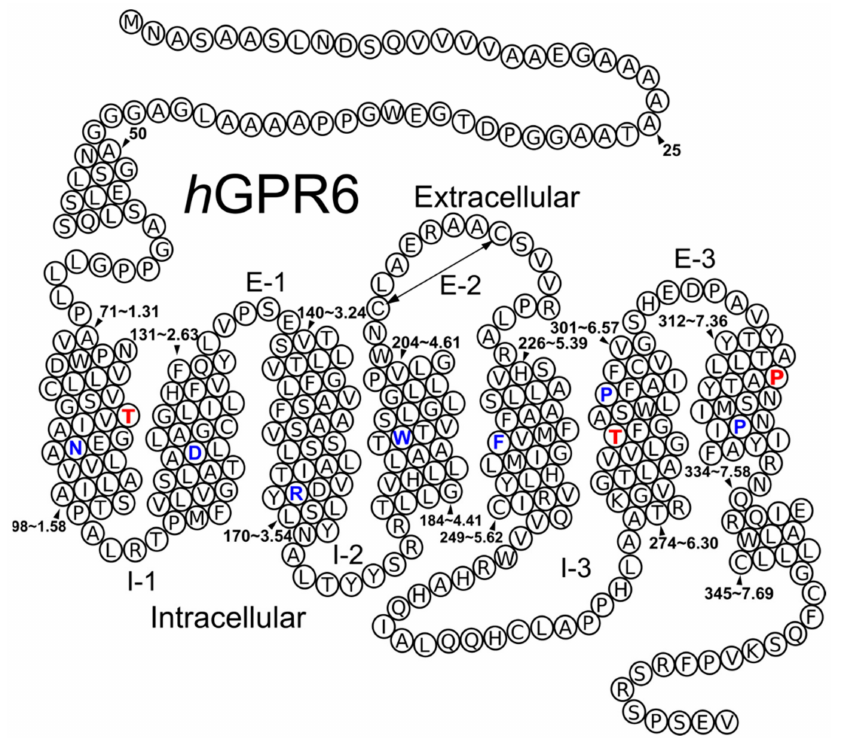
Figure 1. Helix net representation of the human GPR6 sequence. The most highly conserved residue in each helix is colored blue. A key disulfide bridge between the extracellular loop 2 (EC-2) is indicated by a double headed arrow. Black arrowheads indicate specific residue numbers in the GPR6 sequence (absolute and Ballesteros–Weinstein numbering). The additional helix bending residues in TMH1, TMH6 and TMH7 are that were colored